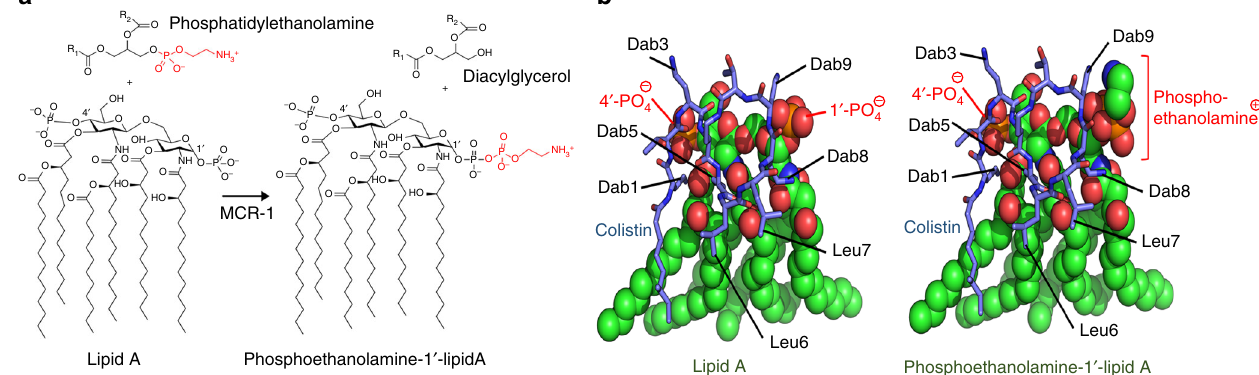
Fig. 1 Molecular model of colistin binding to lipid A. a Schematic of phosphoethanolamine transfer to the 1-PO 4 group of hexa-acylated lipid A as catalysed by MCR-1. b Models of colistin (blue sticks) binding to lipid A (left) or phosphoethanolamine-lipid A (right) (spheres coloured green, red, blue and orange for C, O, N and P atoms, respectively). The model is based on the NMR and docking studies of polymixin B binding to lipid A with lipid A coordinates from PDB 3fxi 22 and colistin coordinates adapted from the NMR structure of polymixin B bound to lipid A 23 . The positively charged Dab colistin residues closely interact with the negatively-charged 1 ′ and 4 ′ phosphate groups of lipid A, reducing the net-negative charge of lipid A. The hydrophobic leucine residues and tail of colistin A interact with the fatty acid tails of lipid A, allowing colistin A to insert into, and disrupt, the bacterial outer membrane. b (right), model of colistin binding to phosphoethanolamine-lipid A indicates addition of positively charged phosphoethanolamine onto the 1 ′ -PO 4 of lipid A likely interferes with the interaction of positively charged Dab8 and Dab9 side chains with the phosphate group, preventing colistin binding to the outer membrane of Gram-negative bacteria. Figure created using Pymol